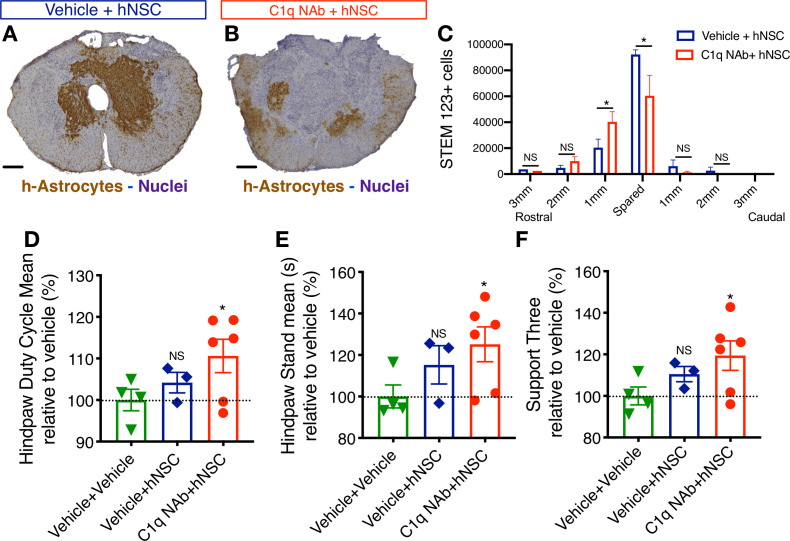
Epicenter C1q neutralization is similar to CD44 KO in modulating hNSC behavior and capacity for repair after acute transplantation.All histological data are from animals sacrificed at 12 weeks post-transplant (WPT). (A,B) Representative images of transverse spinal cord sections corresponding to the injury epicenter area immunostained for the h-Astrocyte STEM123 marker (brown, hematoxylin nuclear counterstain in purple; scale bars, 250 µm). (A) In the absence of C1qNAb, a dense plexus of h-Astrocytes is present near the injury epicenter. (B) A single epicenter injection of C1qNAb in acute SCI microenvironment dramatically decreases the proportion of h-astrocyte at the SCI epicenter. (C) Stereological analysis of STEM123+ h-Astrocytes in the spared tissue adjacent to the SCI epicenter, as well as in 1 mm regions rostral and caudal at 12WPT. Data show mean ± SEM (N = 6 mice per group). Statistical analysis using Student’s t-test for comparison between vehicle + hNSC treated mice and C1qNAb + hNSC treated mice as indicated (*p<0.0261). (D-F) Catwalk kinematic gait analysis at 12 WPT shows that mice receiving C1qNAb + hNSC, but not vehicle + hNSC improves locomotor function in Catwalk kinematic testing vs. mice receiving only vehicle + vehicle. (G) Hindpaw duty cycle (% mean). (H) Catwalk Hindpaw stand mean (s). (I) Support three paws (%), indicating increased weight bearing. Data show mean ± SEM normalized to vehicle+vehicle-treated mice (as explained in Supplementary file 1 only a subset of animals reached sufficient stepping parameters in this experiment to perform on CatWalk N = 3–5 mice per group as shown by individual points in graphs). Statistical analysis using Student’s t-test for comparison between vehicle + hNSC treated mice and C1qNAb + hNSC treated mice as indicated.